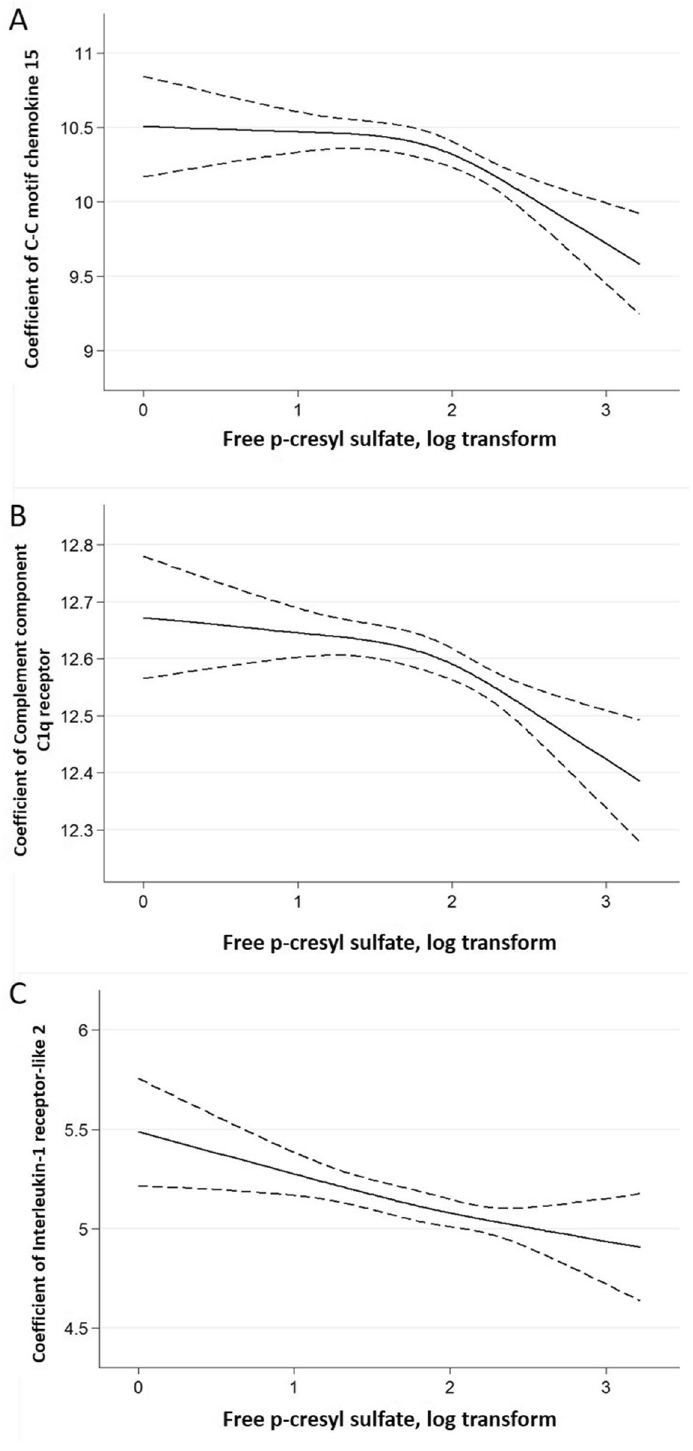
Figure 4. The cubic spline curve between the log-transformed p-cresyl sulfate concentration with 3 knots and selected circulating cardiovascular protein biomarkers NPX units ( A ) C–C motif chemokine 15 (CCL15) ( B ) Complement component C1q receptor (CD93) ( C ) Interleukin-1 receptor-like 2